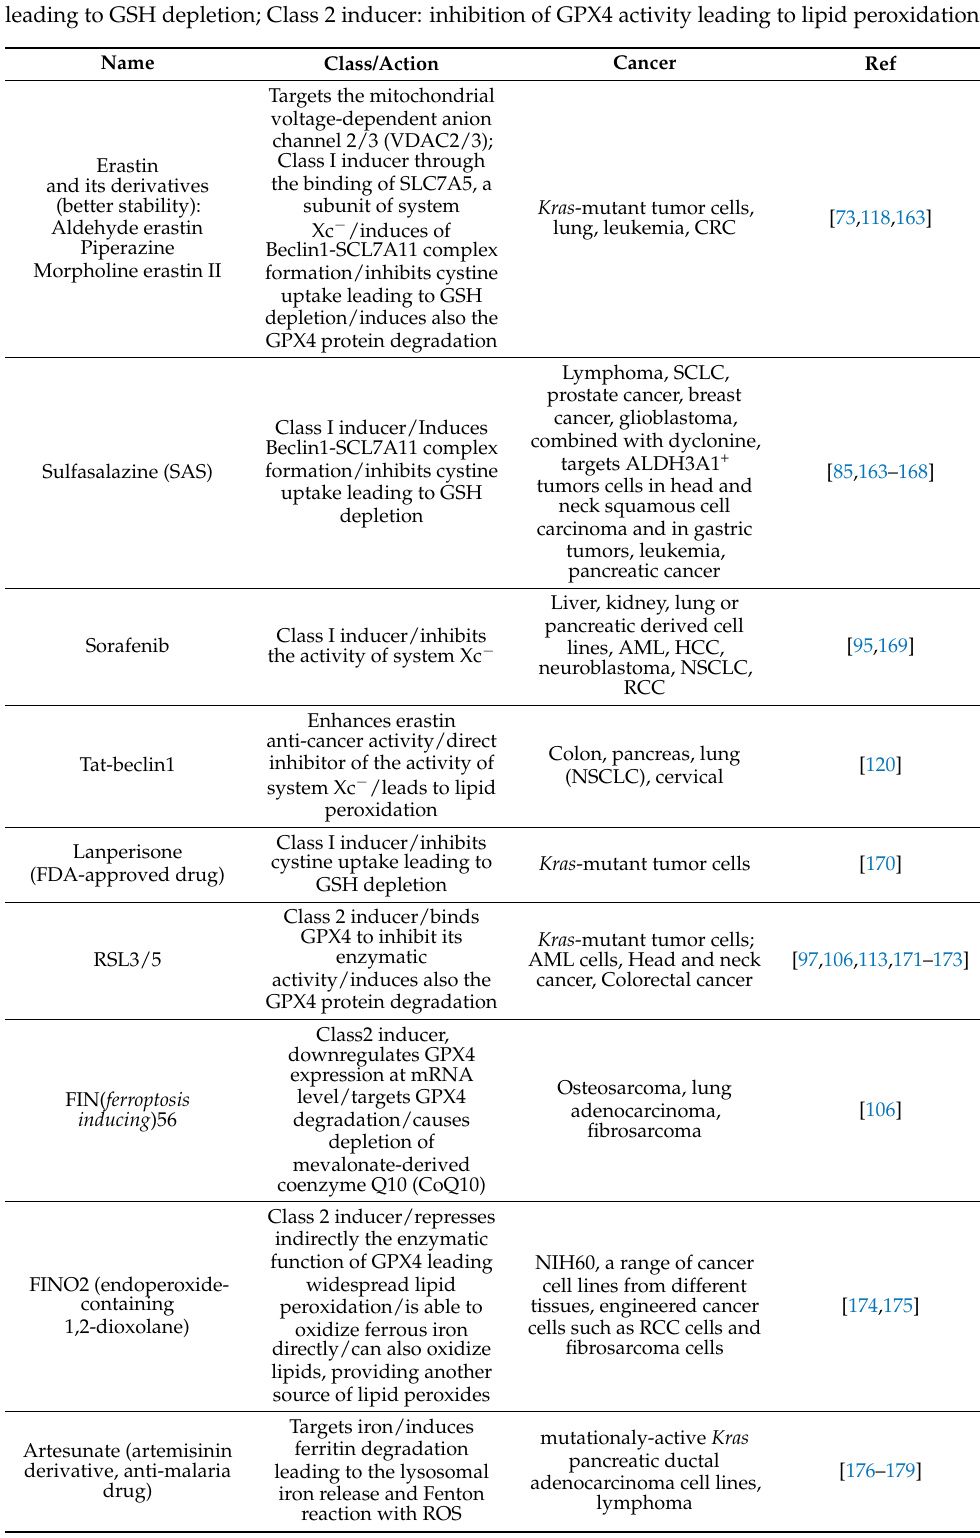
Table 2. Ferroptosis inducers in different cancers. Most ferroptosis inducers are classified into 2 categories on the basis of their mechanism of action: Class 1 inducer: inhibition of system Xc − leading to GSH depletion; Class 2 inducer: inhibition of GPX4 activity leading to lipid